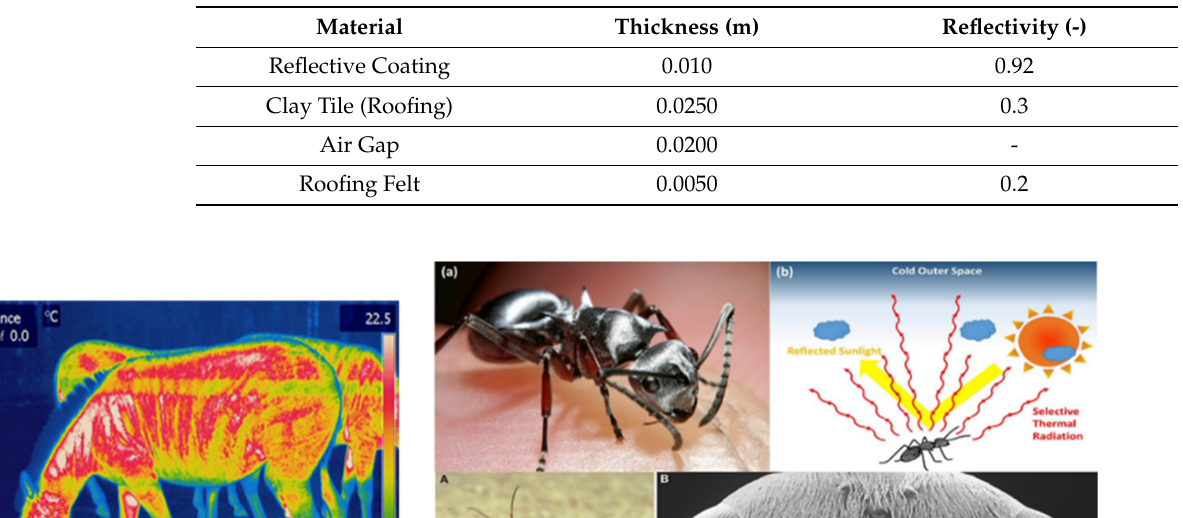
Table 4. Layers in the pitched roofs based on the base case. Own elaboration.